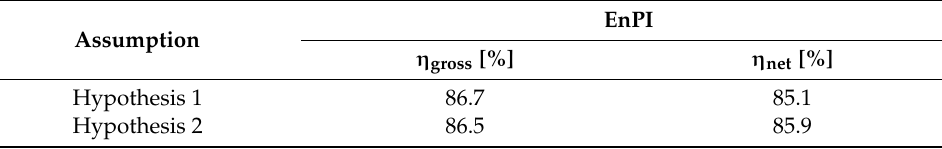
Table 16. Estimated EnPI — according to the predicted optimized CEB.